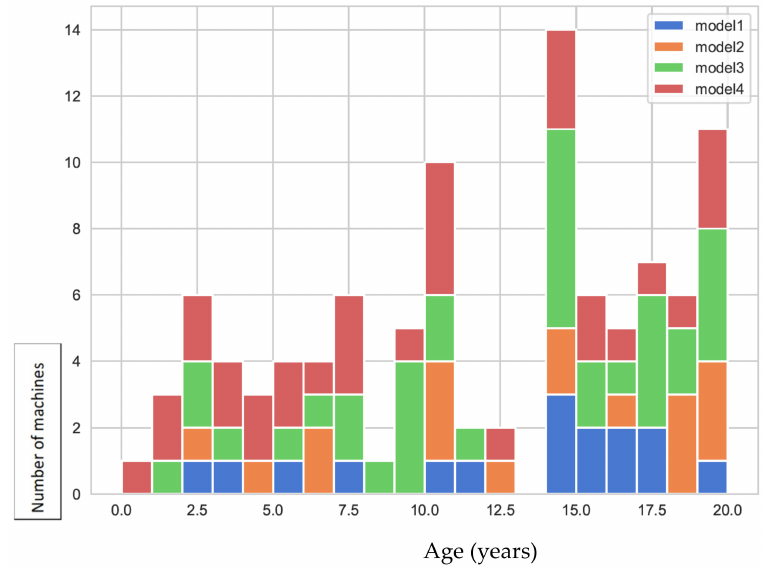
Figure 6. Histogram representing the number of machines and service time, by